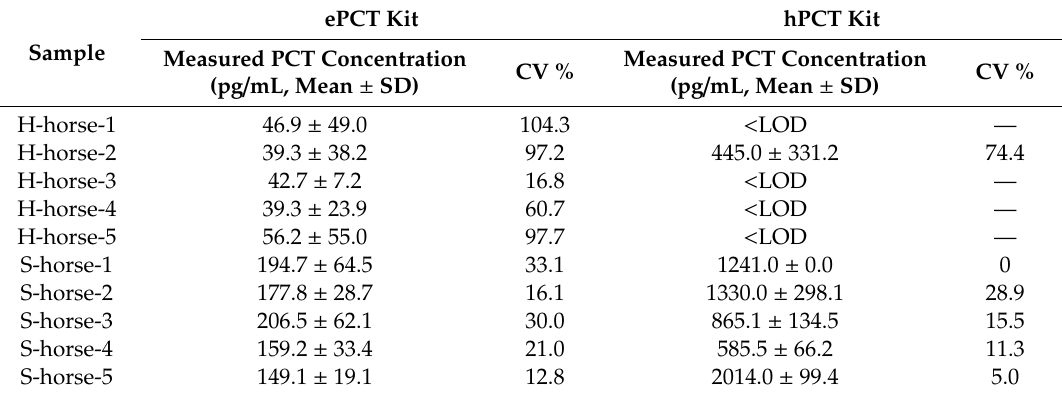
Table 6. PCT concentrations in healthy and sick horses measured with the ePCT and hPCT ELISA kits. CV—coe ffi cient of variation; LOD—limit of